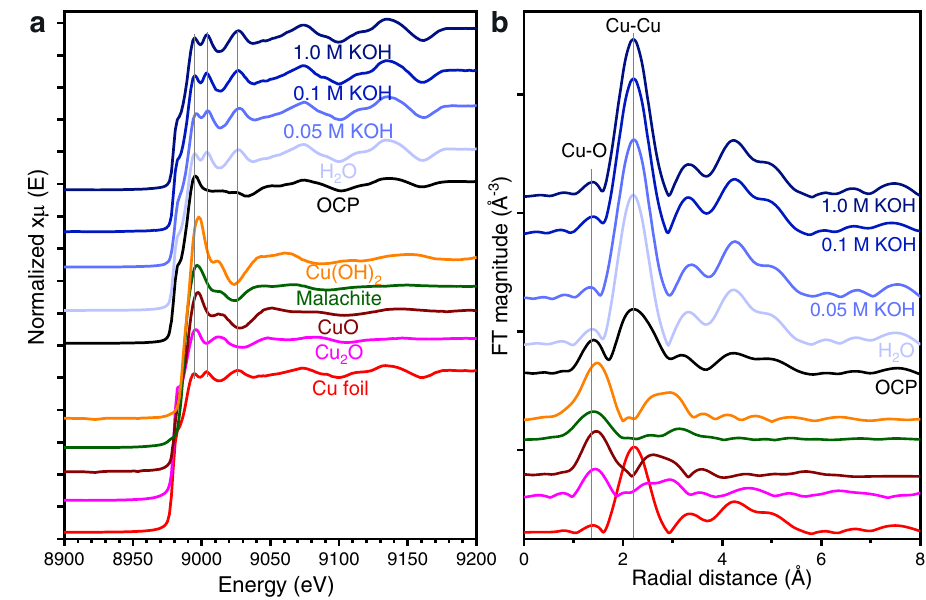
Fig. 4 | Insitu X-rayabsorptionspectroscopy. a in situ Cu K-edge XANES spectra of zero-gap Cu cathodes operated with pure water and different KOH anolyte concentrations (0.05, 0.1, 1.0M) under CO2ER conditions at 3.2V, and b their